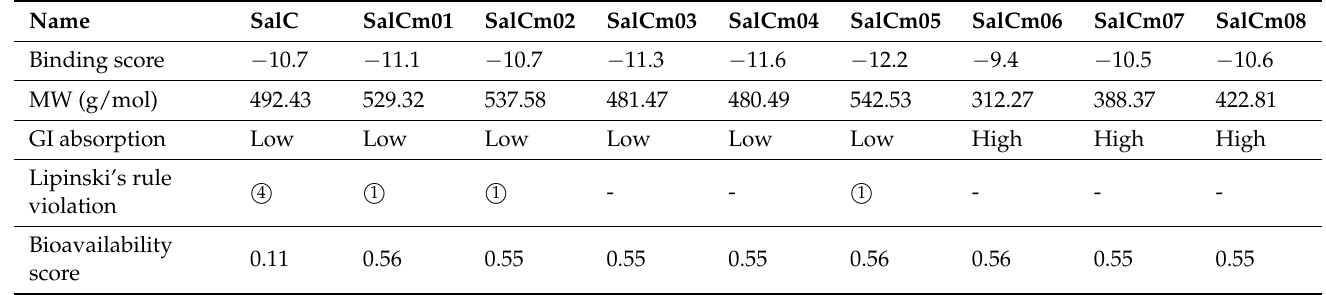
Table 3. SalC Derivative (SalCm01–08 series) with ADME parameters.